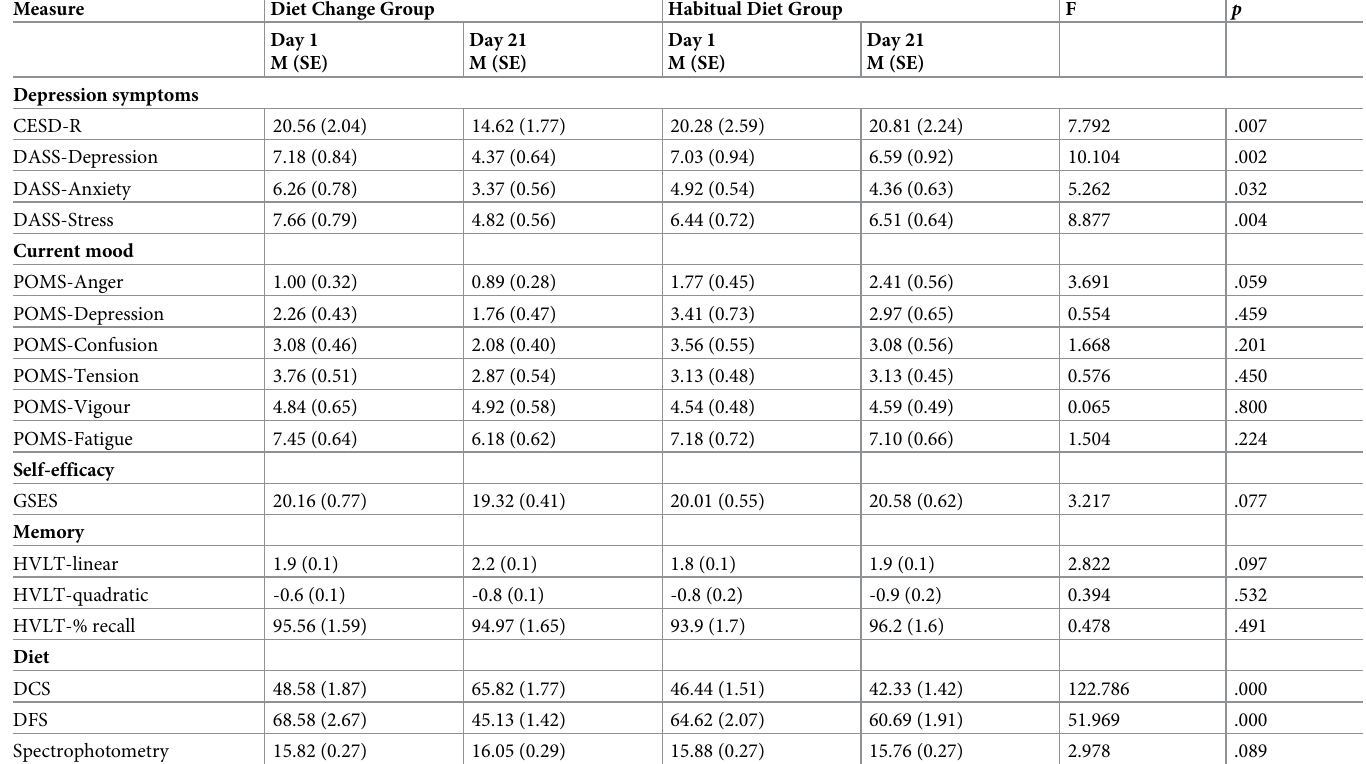
Table 3. Mean ( ± standard error) scores for diet change and habitual diet groups on the primary and secondary outcome measures, as well as results of ANCOVA comparing groups at Day 21 while controlling for Day 1 scores. Measure Diet Change Group